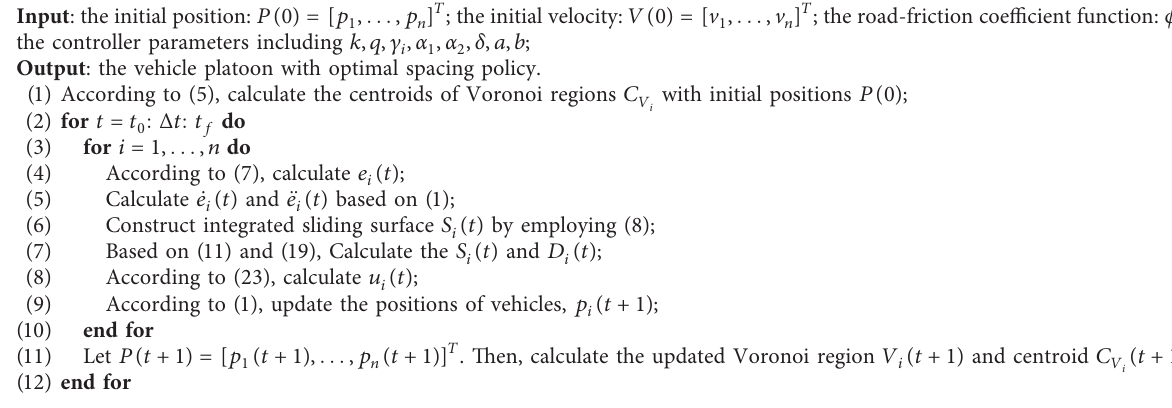
A LGORITHM 1: The vehicle platoon control algorithm with optimal spacing policy.